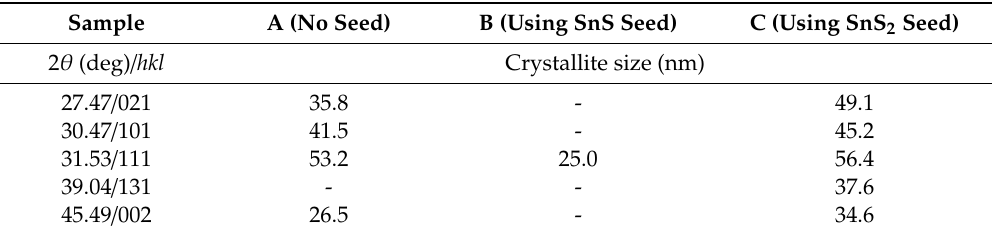
Table 2. Calculated crystallite size for each { hkl } plane of SnS films using various seed layers.